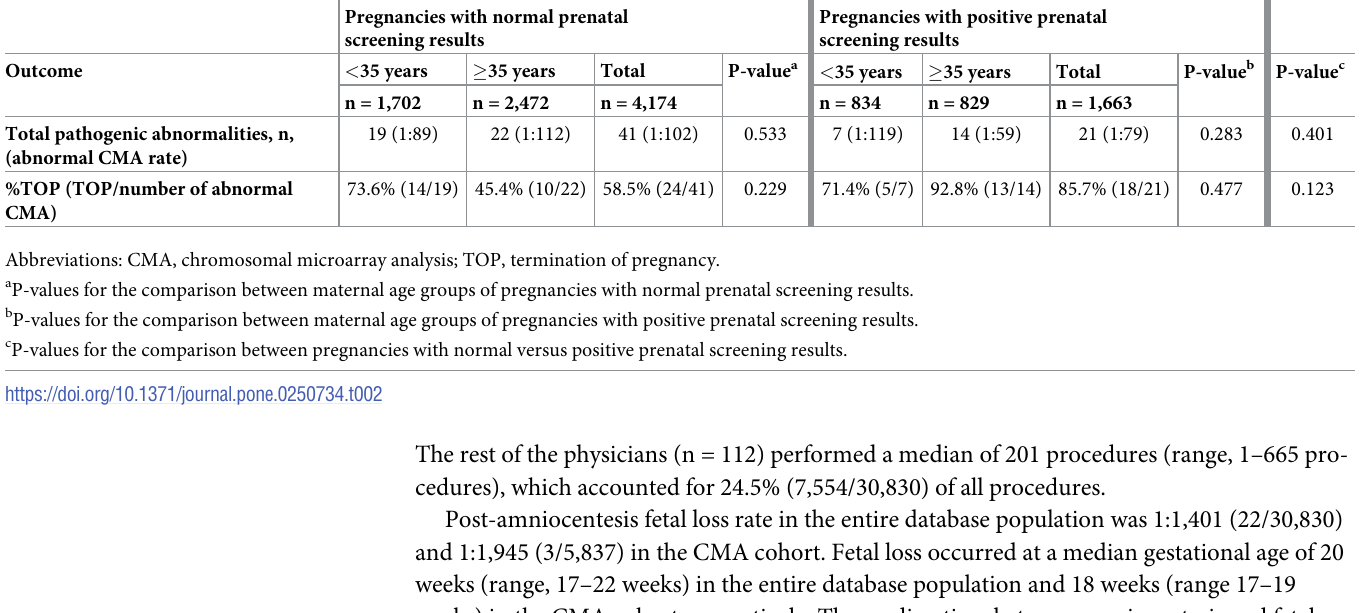
Pregnancies with positive prenatal screening results